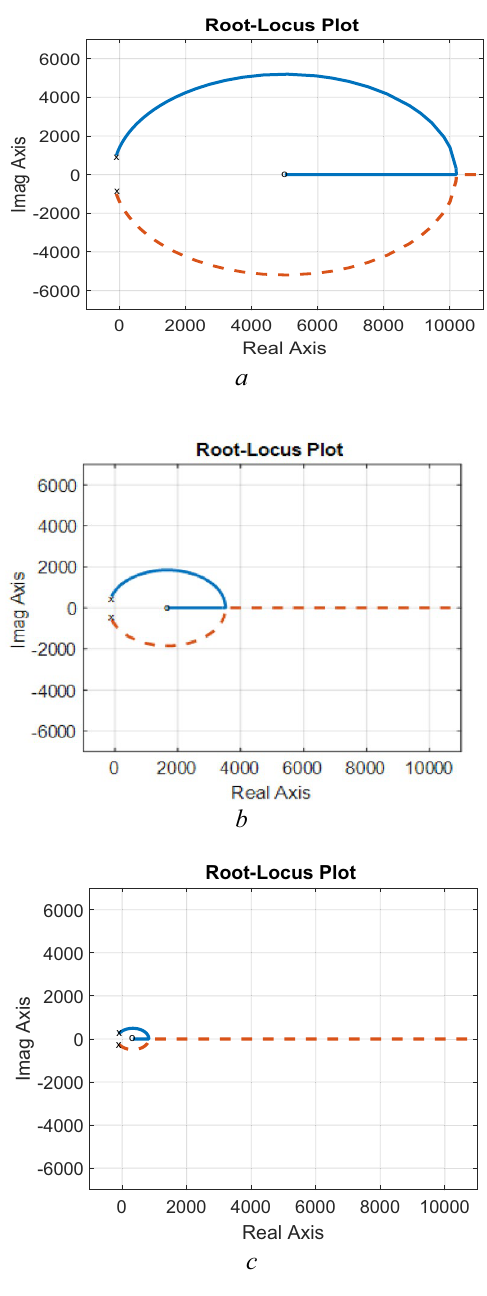
Figure 4. Effects of varying the inductance, Pole-Zero. ( a ) L = 5 mH, C = 50 µF, ( b ) L = 15 mH, C = 50 µF, ( c ) L = 75 mH, C = 50